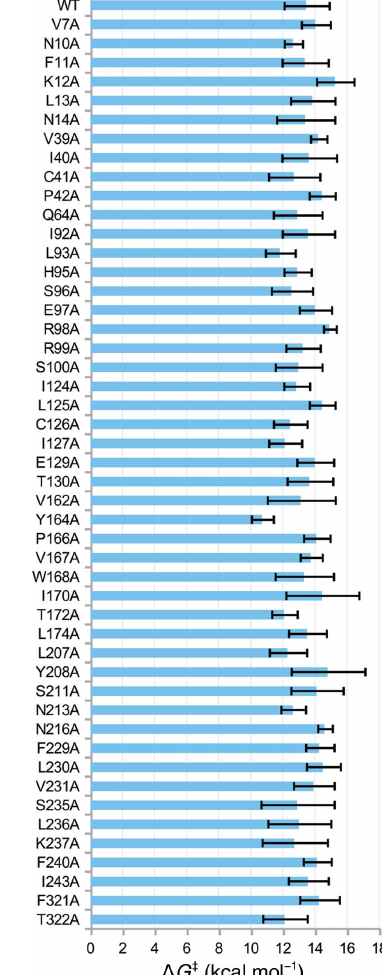
Figure 8 Results of the initial alanine scan. Activation energies ( (cid:2) G ‡ ) are given as median values, with error bars displaying the standard deviation over 24 individual EVB simulations. The corresponding raw data are provided in Supplementary Table